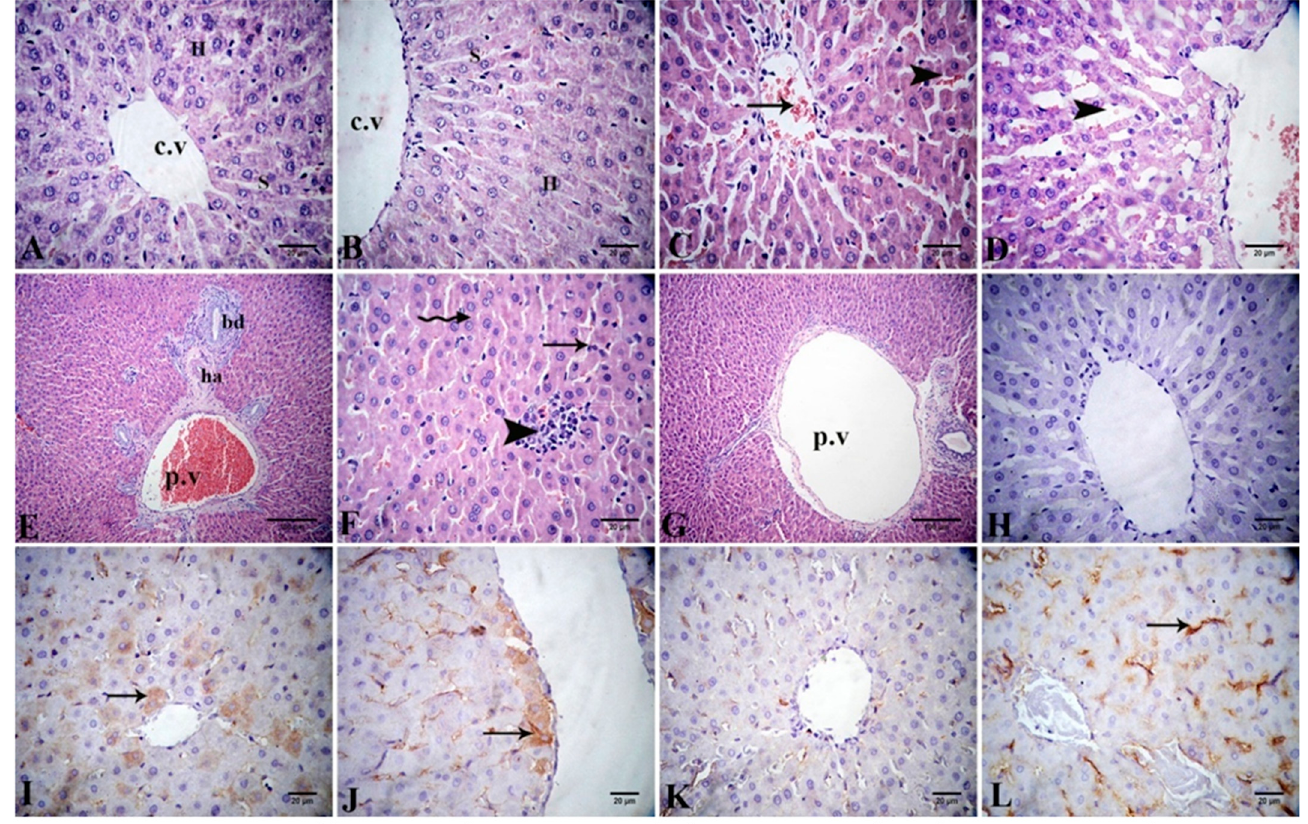
Figure 5. ( A – G ) Photomicrograph of liver tissue sections stained with H&E revealing normal histological structure of the central vein (c.v), hepatocytes (H), and sinusoids (S) in the control ( A ) and Alhagi-administered groups ( B ). The lead-intoxicated group demonstrates congestion of central vein (arrow) and in hepatic sinusoids (arrow head) ( C ), severe dilatation of sinusoids (arrow head) ( D ), congested portal vein (p.v) beside hepatic artery (ha), and bile ductule (bd) in the portal area ( E ) and lymphocytic infiltration (arrow head), disruption of hepatocytes (zigzag arrow) and apoptotic hepatocytes (arrow) ( F ). The lead + Alhagi-treated rats demonstrate mild dilation in the portal vein (p.v) ( G ). ( H – L ) Photomicrograph of the liver tissue sections displaying Bcl-2 immunoexpression (arrows) as the following: negative in the negative control ( H ), moderate in the control ( I ), moderate in the Alhagi-administered rats ( J ), negative to weak in the lead-intoxicated rats ( K ), and mild in the lead + Alhagi-exposed rats ( L ). Table 5. Lesion scoring in the liver and brain tissues of rats in response to lead (100 mg/kg BW, orally) and A. maurorum extract (300 mg/kg BW, orally) treatments daily for 3 months.